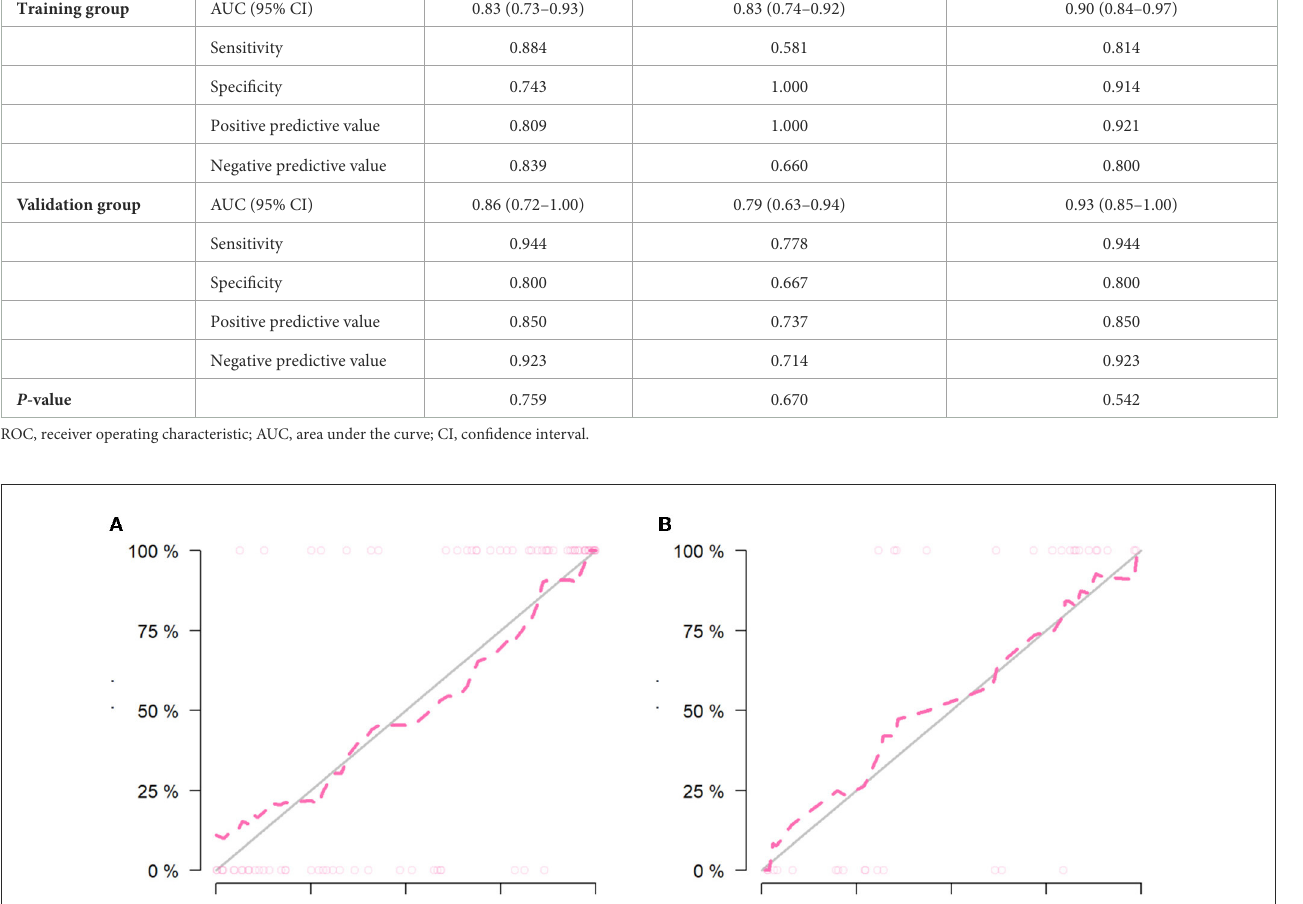
and Left_Idmn). Smaller skewness reflected the left deviation of the image, and more voxels were high intensity. Macroscopically, the higher intensity of left globus pallidus increased the risk of ABE. Smaller Left_Maximum2DDiameterRow and larger Right_SurfaceVolumeRatio were correlated closely with the risk of ABE. We speculated this was due to the neurotoxicity of unconjugated bilirubin increasing the influx of calcium ions, stimulating the activity of proteolytic enzymes, and leading to apoptosis (20, 24), changing the shape and volume of GP. The texture features described the distribution of voxel intensity and the spatial relationship between local adjacent voxels, which were a comprehensive reflection of the intrinsic properties of the image, and they could quantify the complexity of the texture of bilateral GPs in neonatal with ABE. However, associating a single texture feature with complex biological processes remains a challenge. These texture features included in the radiomics model may reflect the heterogeneity of bilateral GPs in neonatal with ABE. Liu et al. (25) also established models to distinguish between ABE and healthy neonates based on T1WI, and the best model obtained good diagnostic efficiency with an AUC of 0.946. Wu et al. (26)